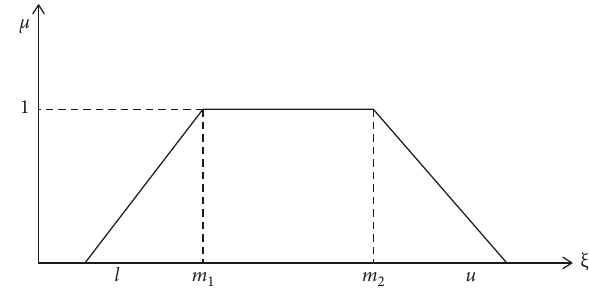
Figure 1: Trapezoidal fuzzy number.